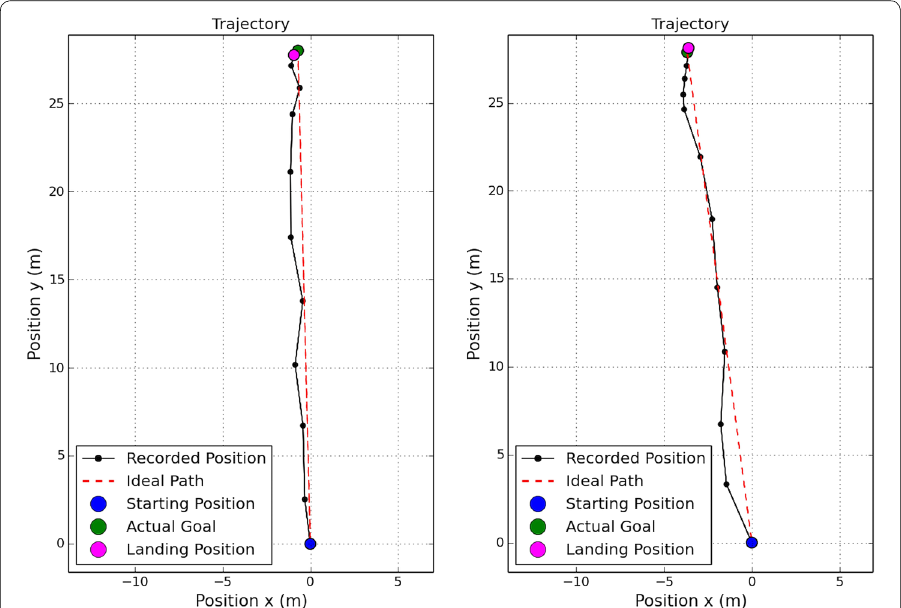
Fig. 11 Drone navigation algorithm trajectory from first experiment (left) and Drone navigation algorithm with course-over-ground trajectory from first experiment (right)